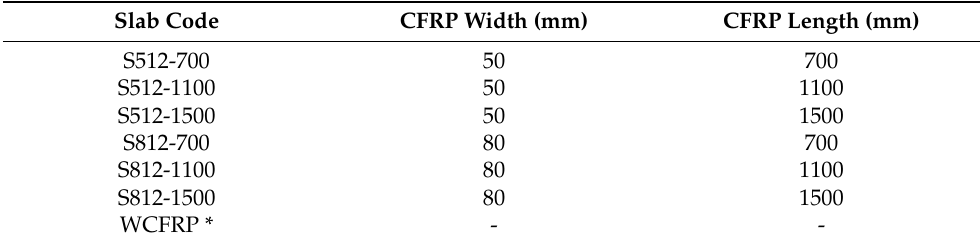
Table 7. Tested slabs and properties of CFRP laminates.